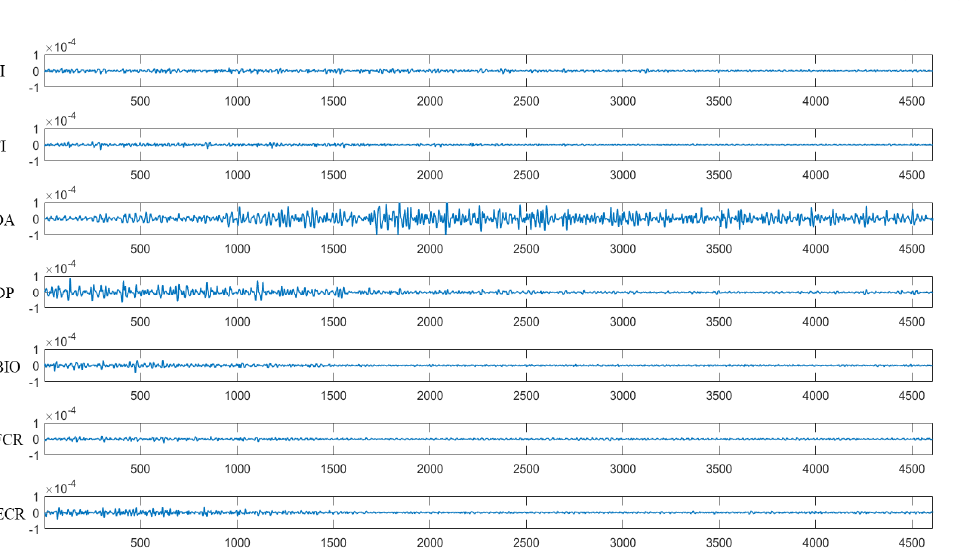
Figure 1. The upper limb movement experiment based on the rehabilitation robot.